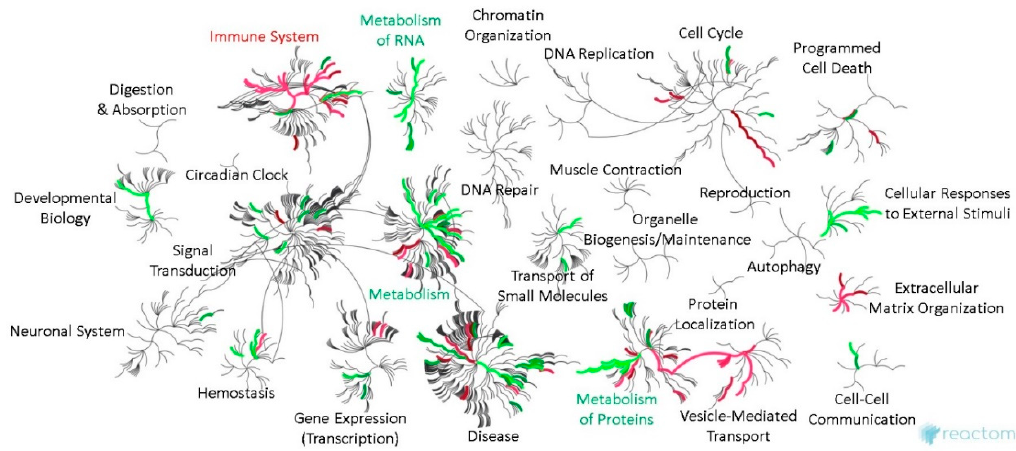
Figure 3. Genome-wide overview of bioinformatic pathways in metastasizing and non-metastasizing pUM. Reactome pathway analysis results are illustrated in network view for DE proteins elevated in metastasizing pUM ( n = 191, red) and for those elevated in non-metastasizing pUM ( n = 211, green). Top level Reactome pathways are labeled and displayed in circular bursts, with each step away from the center representing a lower level in pathway hierarchy. The color coding reflects over-representation of the pathway and no color signifies little, if any, pathway representation. See Supplementary Tables S7 and S8 for pathway details.